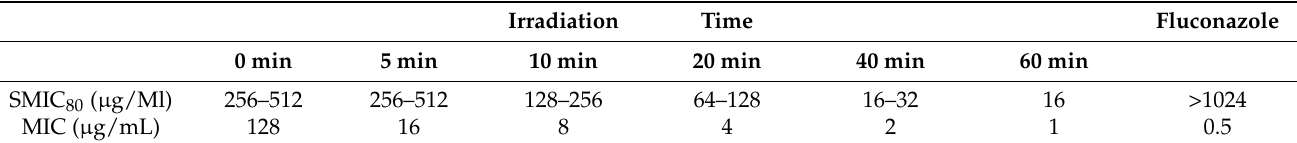
Table 2. The MICs and SMIC 80 s of EA, against Candida albicans and its biofilm.